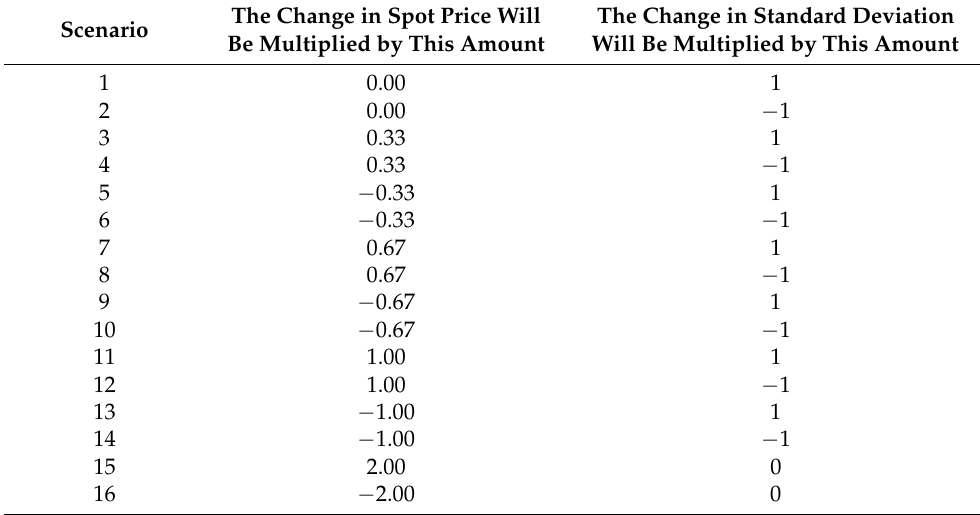
Table 5. SPAN scenario